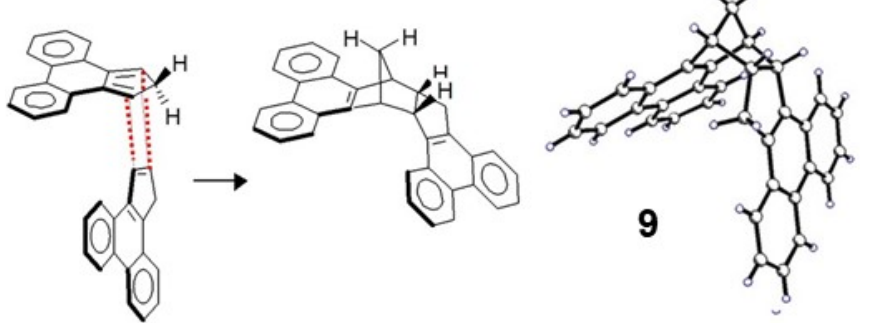
Figure 2. Molecular structure of the Diels–Alder dimer, 9 , formed by reaction of cyclopenta[ l ]phenanthrene with its own isoindene.